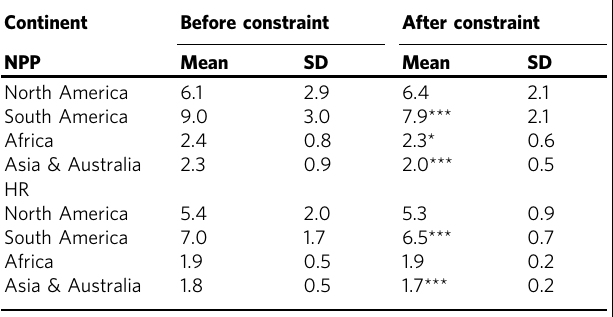
Table 1 Modeled projected (period 2015 – 2099, units in Pg C y − 1 ) grid-level NPP and grid-level HR before and after constrain across the continent in six